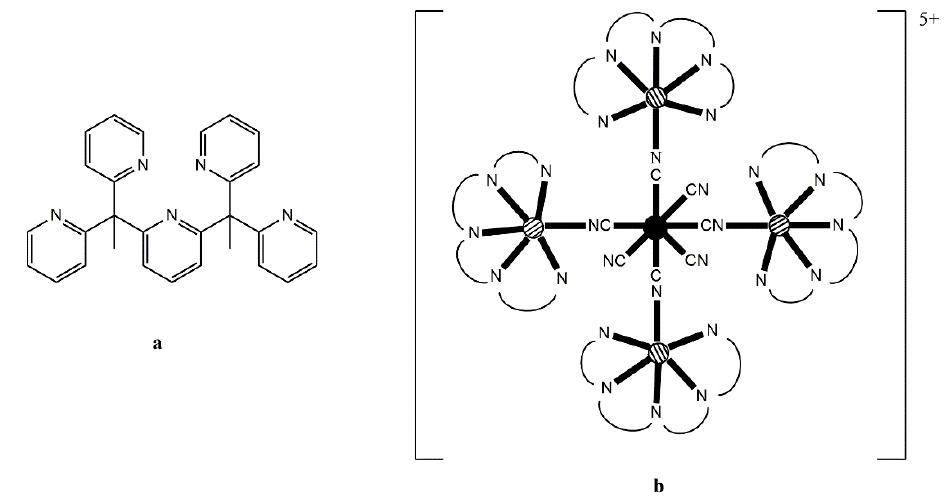
Figure 9. ( a ) The structural formula of the “open” pentadentate ligand PY5Me 2 . ( b ) Schematic drawing of the molecular structure of the pentanuclear {Mn II 4 Re IV } cation that is present in 13 ; the solid circle represents the Re IV atom, the semi-dashed circles represent the Mn II atoms and NˆNˆNˆNˆN represents the pentadentate chelating ligand PY5Me 2 , while the coordination bonds are drawn with bold lines.